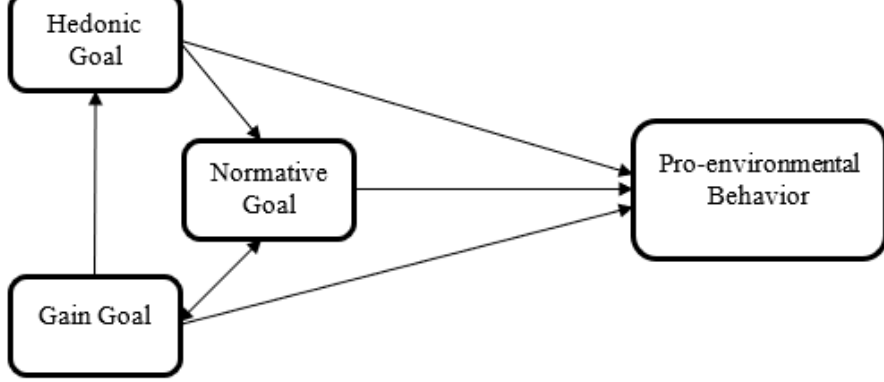
Figure 3: Goal Framing Theory (Chakraborty et al., 2017; Lindenberg & Steg, 2007; Rezvani et al.,